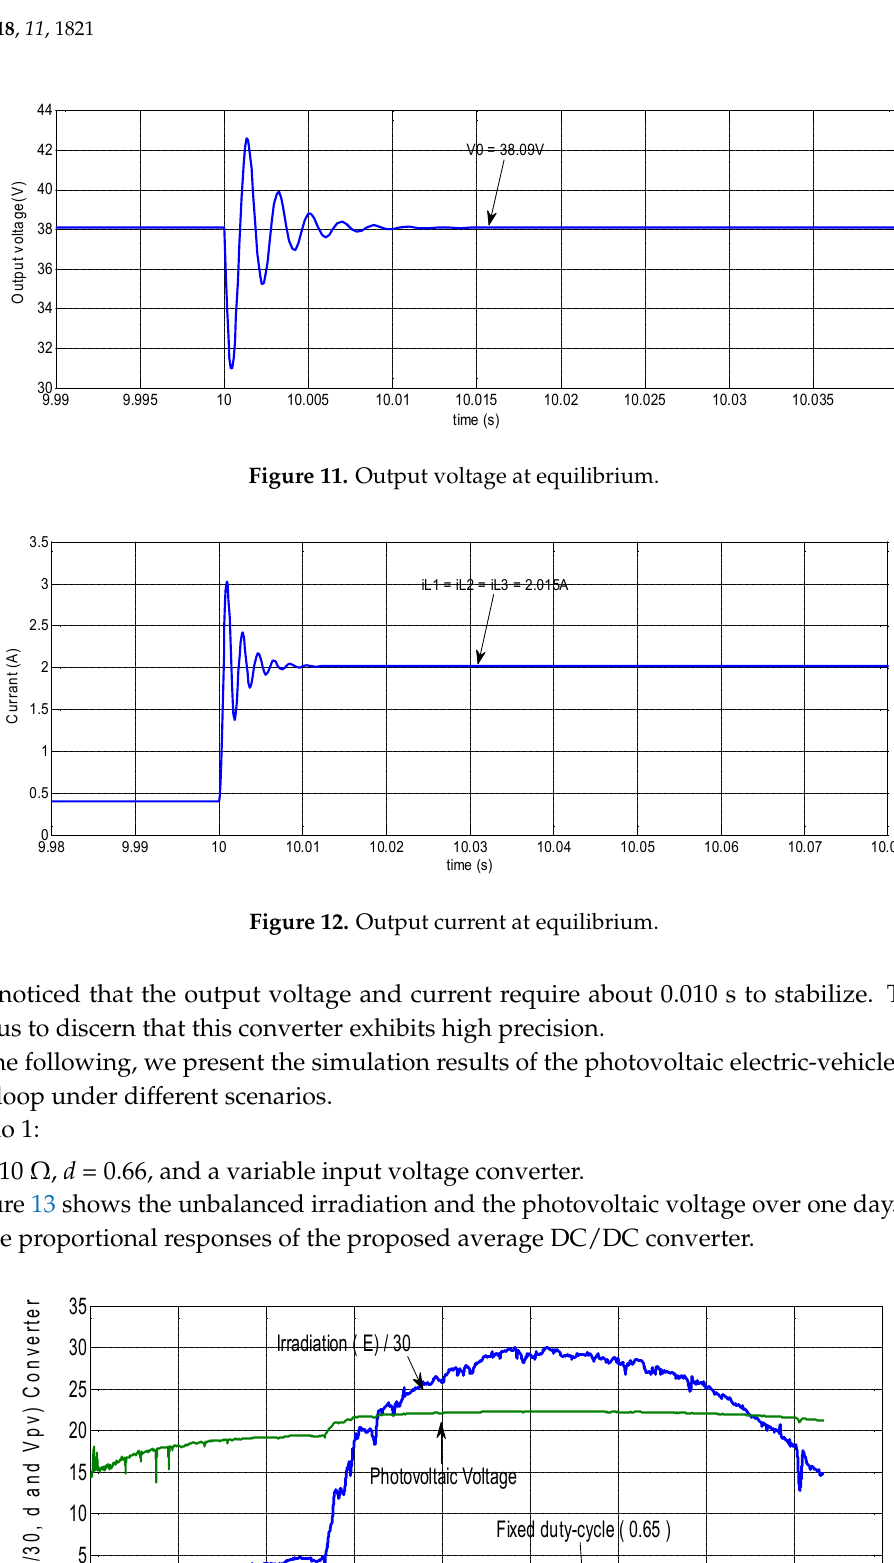
Figure 14. Outputs (V0, i L , and power) from the converter vs. time. We note that the bivariate polynomial is used for the simulation of the system where both irradiation and temperature are variable. In stand-alone photovoltaic power systems, the output voltage is effectively a constant DC bus (Figure 14 with red color).  Figure 15. Output voltage vs. time to variable duty cycle.